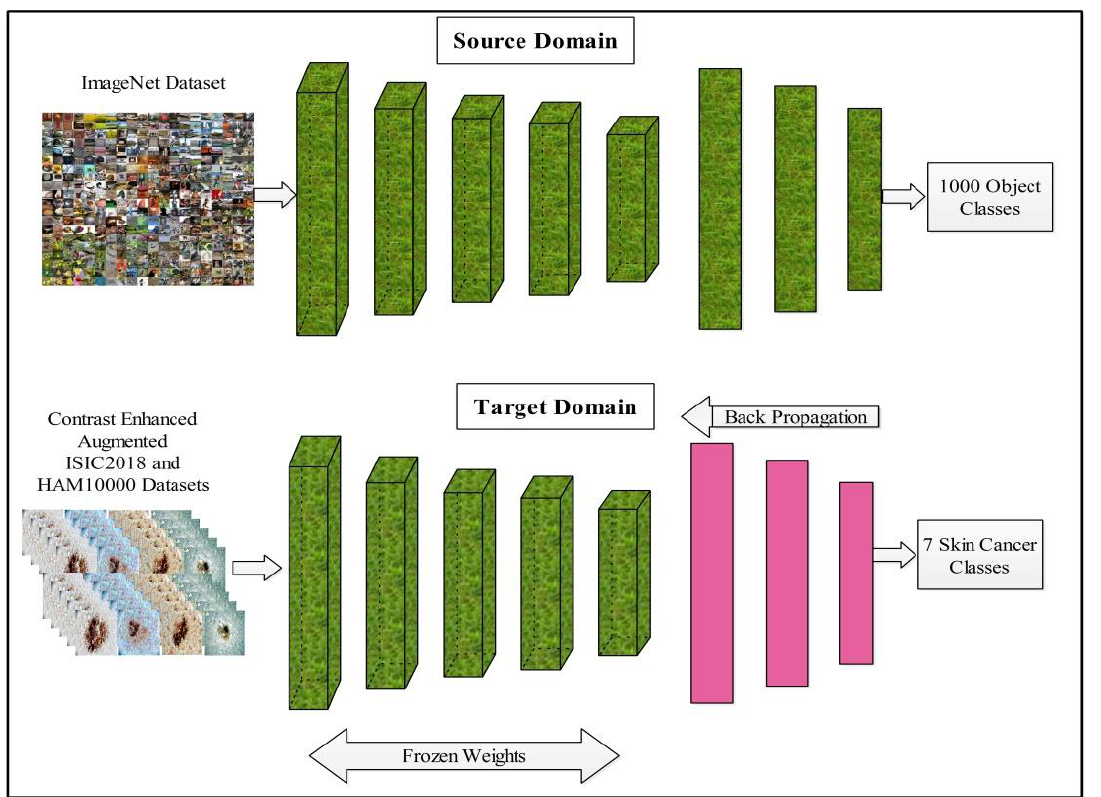
Figure 7. Transfer learning based model learning and features extraction.